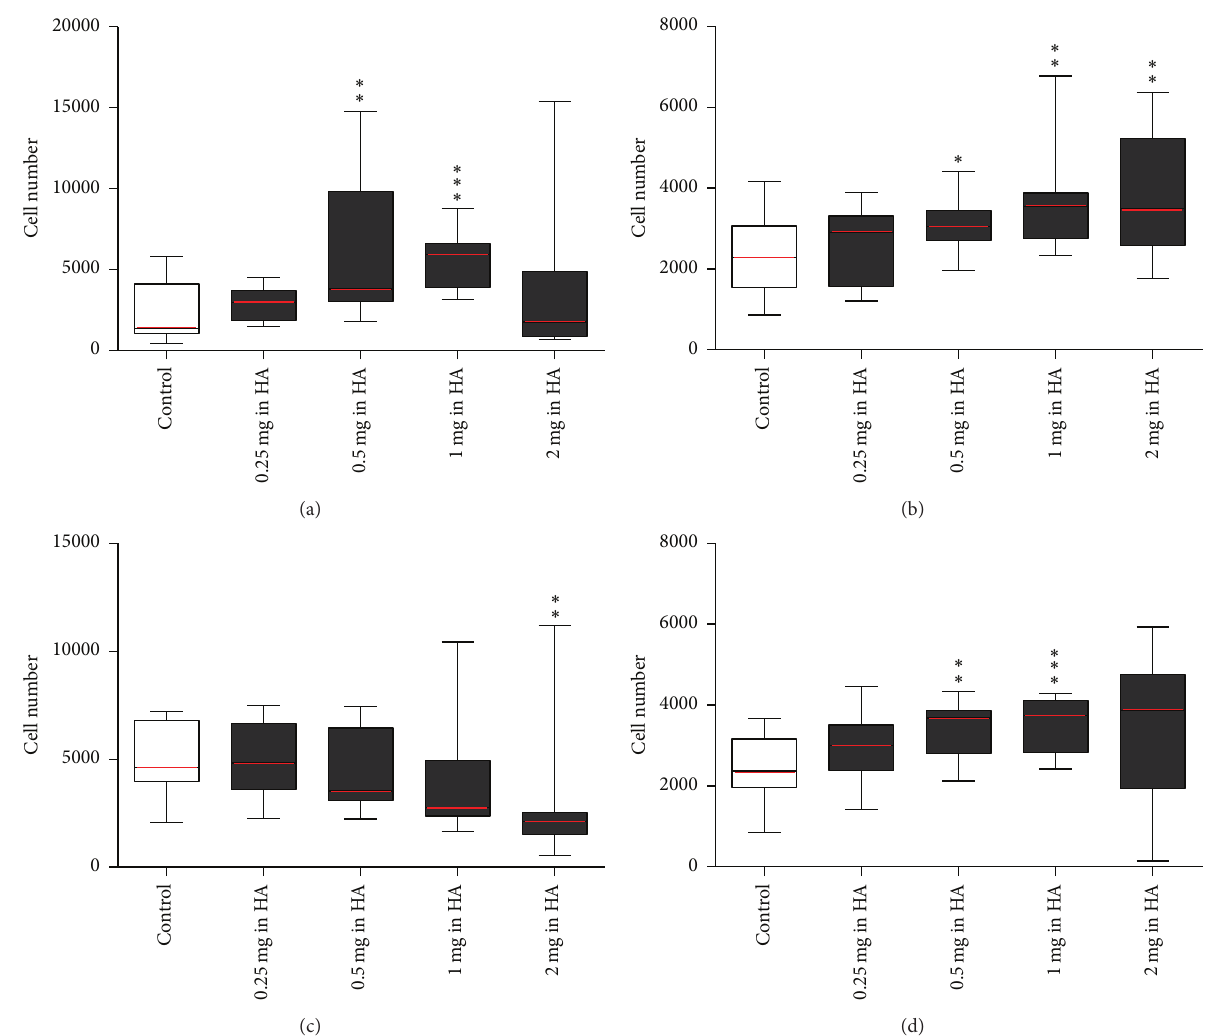
Figure 3: MSCs grown in HA media and seeded HA media. MSCs expanded until passage 2 in control media. Cells were then stripped and cell suspensions were counted using the standard enumeration technique. Cells grown control media, flask (A), were seeded in control media (control) ( − − ) and MSCs grown in flasks (B–E) HA media were seeded into 96-well plates in HA media with the same concentration of HA (+ +) ranging from 0.25 to 2mg/mL of HA to make up the five conditions ( 𝑥 -axis). Conditions were tested using five technical replicates per 96-well plate and run in biological triplicate ( 𝑛 = 3 ). Wells were assayed at the endpoint using Cell Counting Kit-8 with standard curves run on every 96-well plate seeded 24 hours prior to endpoint and absorbance read at a wavelength of 450 nm ( 𝑦 -axis). All conditions were compared back to the control using a 𝑡 -test ( ∗ 𝑝 value < 0.05, ∗∗ 𝑝 value < 0.01, and ∗∗∗ 𝑝 value < 0.001). (a) MSCs seeded in standard 96-well plates for 24 hours (adherence), (b) MSCs seeded in standard 96-well plates for three days (proliferation), (c) MSCs seeded in high -adherence 96-well plates for 24 hours (adherence), and (d) MSCs seeded in high -adherence 96-well plates for three days (proliferation) (see Supplementary Table